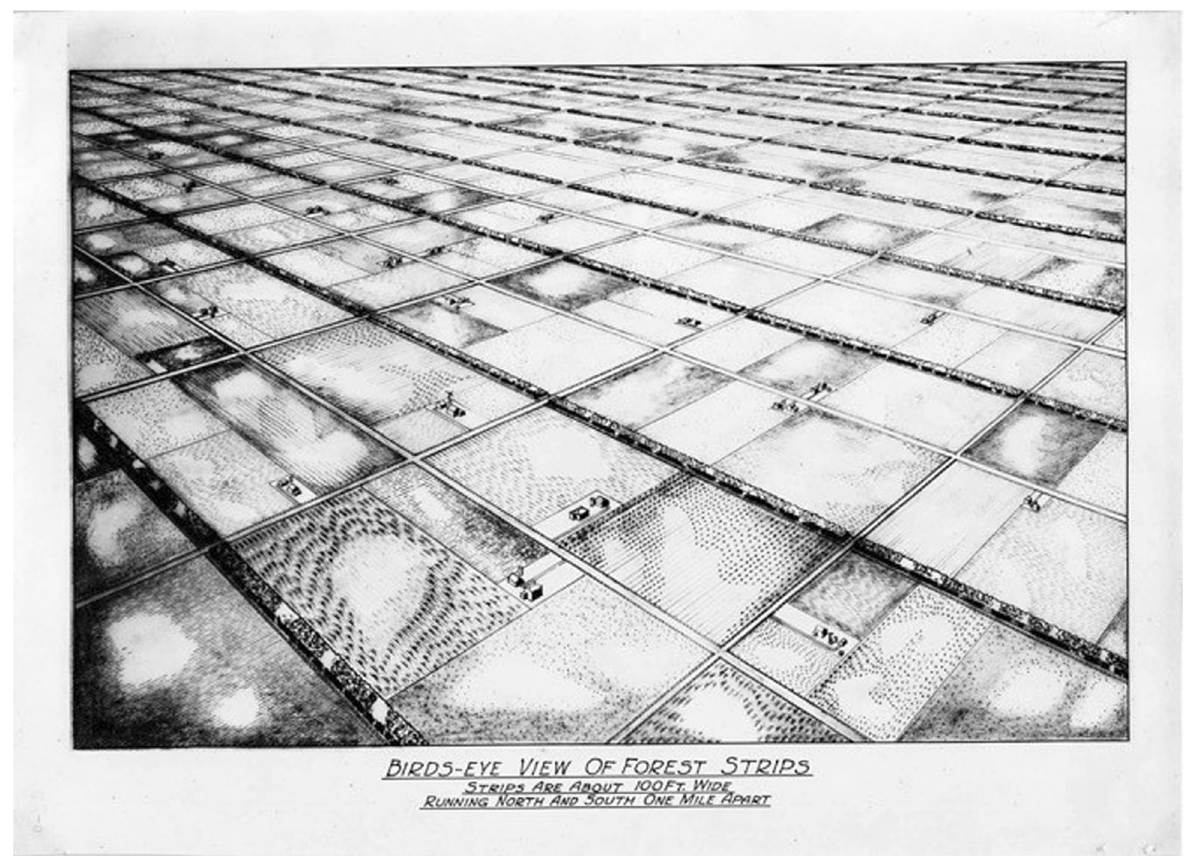
Fig. 3 Artistic representation of shelterbelt spacing. Strips are about 100 ft wide, running north and south one mile apart. Lake States Forest Experiment Station. 1934. (Source: the Forest Service,